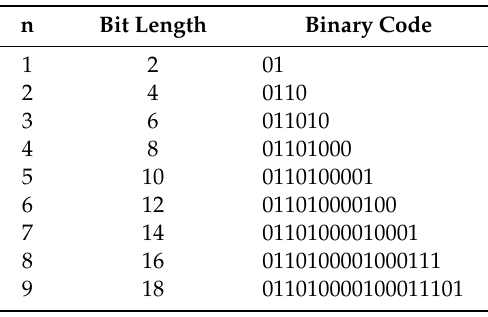
Table 1. Binary code of different n.